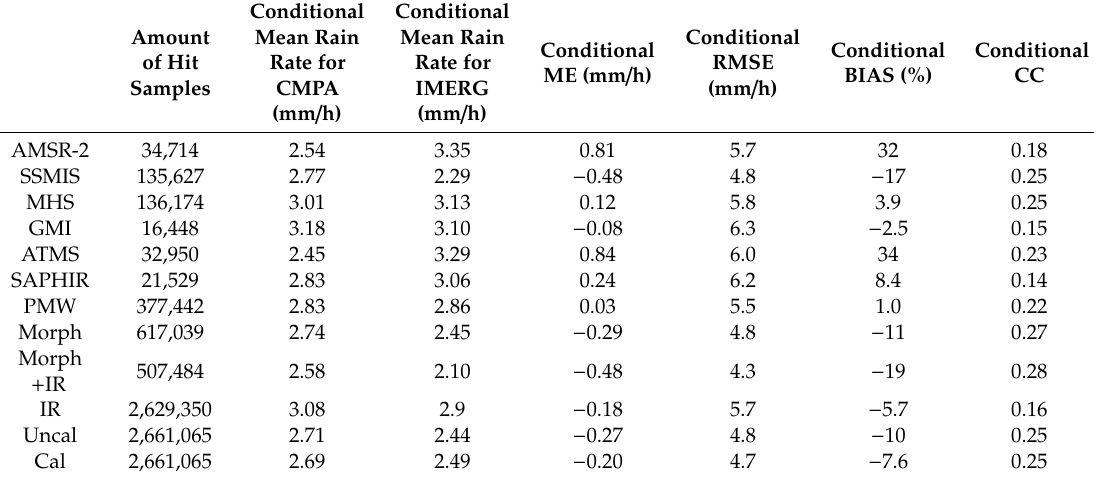
Table 4. Statistical comparison of the hit data pairs for 12 categories of IMERG estimates and corresponding CMPA